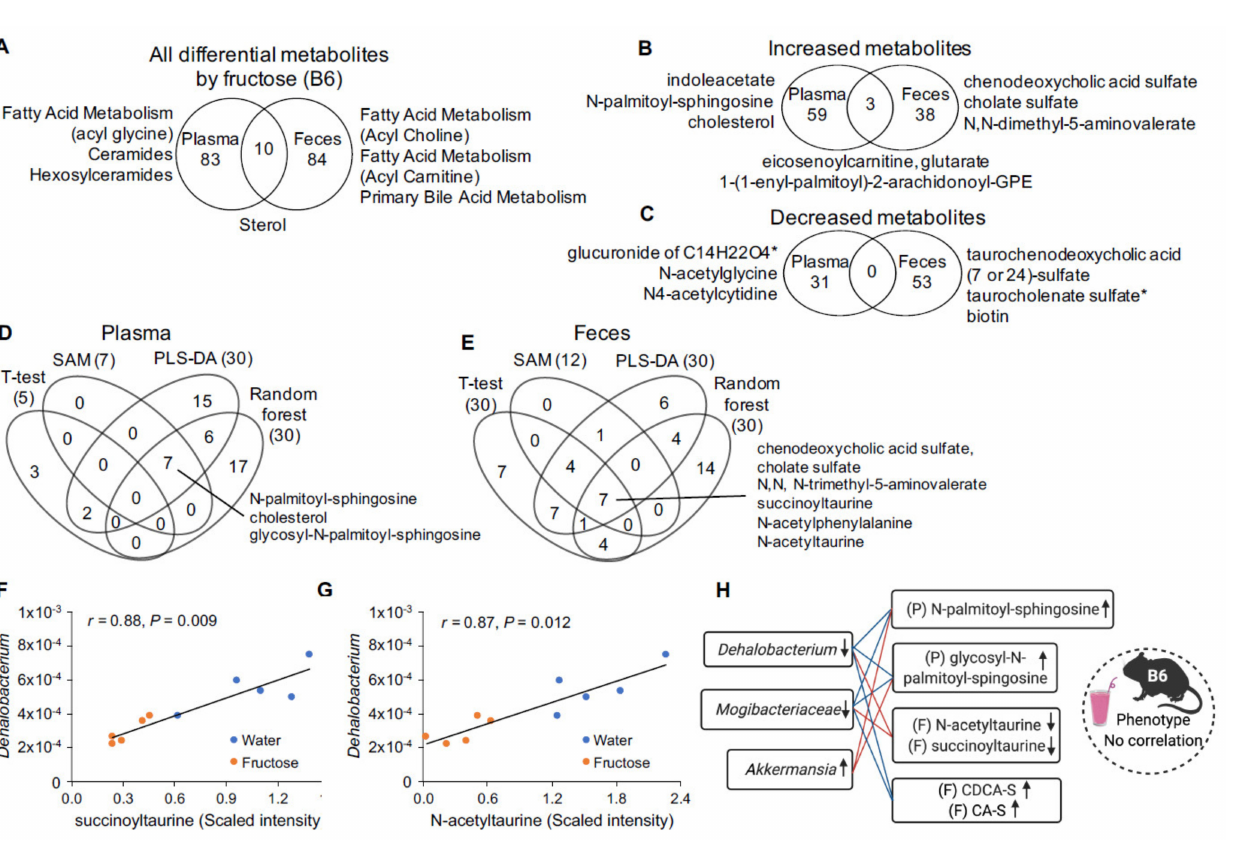
Figure 3. Fructose-responsive metabolites in plasma and feces of B6 mice. ( A ) Venn diagram showing the number of fructose-responsive metabolites and the representative top pathways that were overlapping or unique between plasma and feces of B6 mice. ( B , C ) Venn diagrams showing the number of the increased ( B ) and decreased ( C ) metabolites by fructose and the top metabolites that were overlapping or unique between plasma and feces of B6 mice. ( D , E ) Venn diagrams representing overlapping significant metabolites altered by fructose in plasma ( D ) and feces ( E ) across four statistical methods: statistical significance level ( t -test/fold change), Significance analysis of metabolites (SAM), Partial-least squares discriminant analysis (PLS-DA), and Random forest. ( F , G ) Correlation plots between metabolites and fructose-responsive microbiota (proportion, 0–1) of B6 mice with or without fructose treatment. r, Biweight midcorrelation (bicor) coefficient; P , Benjamini-Hochberg adjusted p -values. ( H ) Summary of the correlative relationships between fructose-responsive microbiota, metabolites, and metabolic phenotype of B6 mice. Increased or decreased microbiota, metabolites, and metabolic phenotype upon fructose consumption were indicated by up or down arrows, respectively. CDCA-S, chenodeoxycholic acid sulfate; CA-S, cholate sulfate; P, plasma; F, feces. n = 5–6/group/strain. Fructose-responsive metabolites were determined by ANOVA contrasts ( p < 0.05). Symbol (*) next to metabolites indicates that the compounds have not been officially confirmed based on a standard, but confident in its